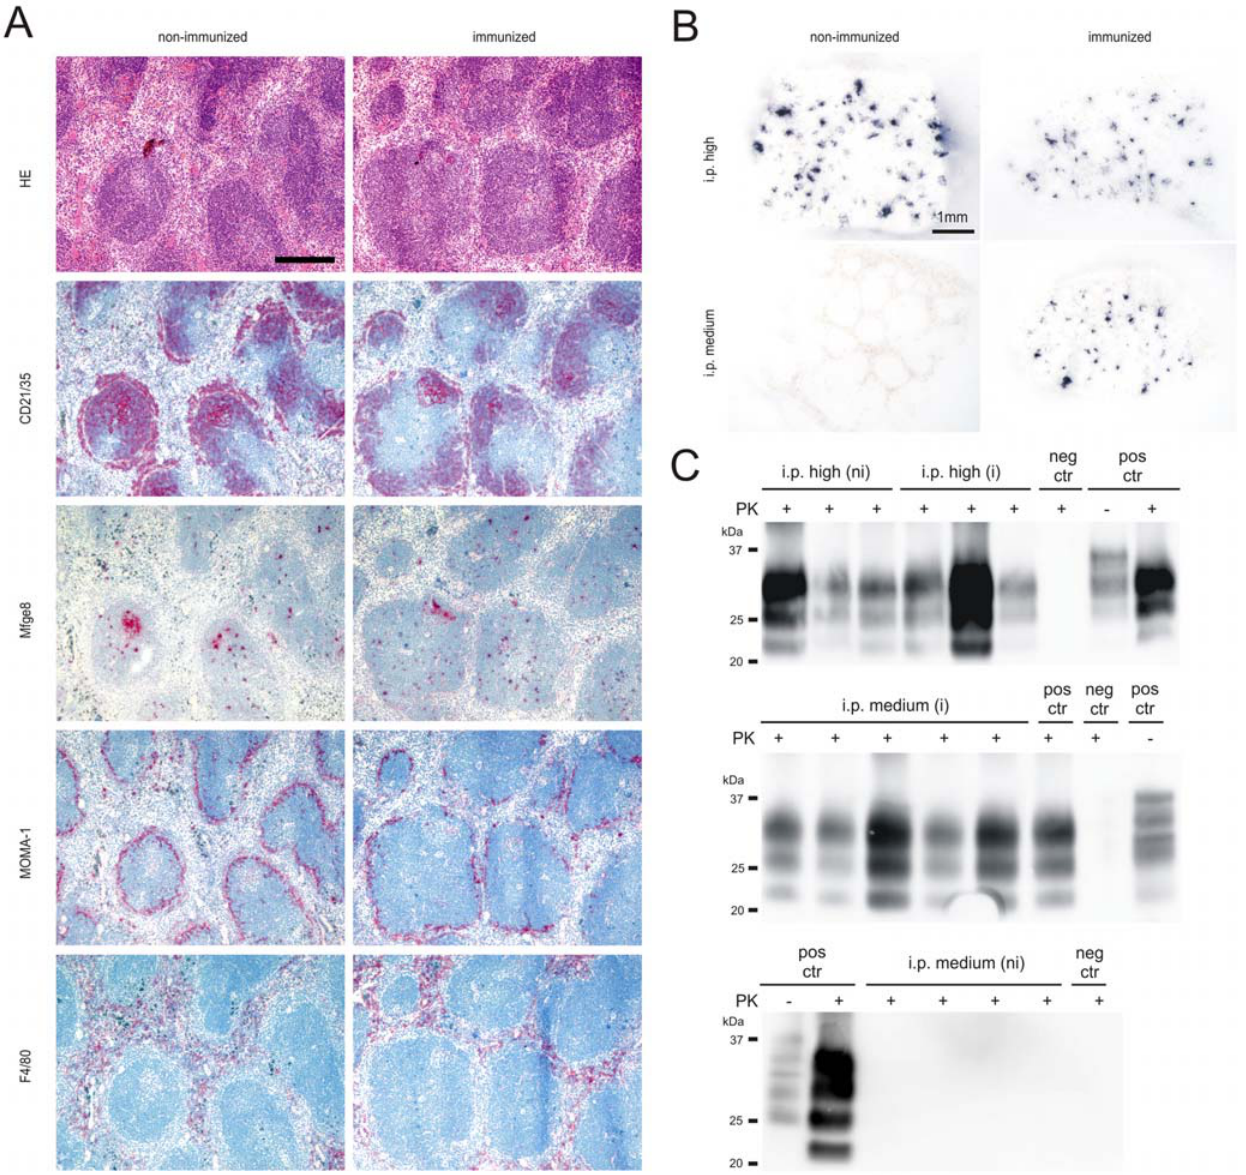
Figure 7. Histology, histoblots, and Western blots of spleens from terminally sick or asymptomatic mice. (A) Spleens of immunized (i) and non-immunized mice (ni) inoculated intraperitoneally (i.p.) with medium or high dose of prions were analyzed by histology. Histological and immunohistochemical stains were performed as indicated. MOMA-1 + cells were reduced in immunized mice. All terminally sick mice of the various experimental groups carried PrP Sc in their spleens as shown by histoblot (B) and confirmed by Western Blot (C) . Asymptomatic, non-immunized mice inoculated i.p. with a medium dose of prions [i.p. medium (ni)] were killed at 400 dpi. No PrP Sc was detectable by histoblot analysis (B) and Western blot analysis (C) . Controls and abbreviations are as in Fig. 6. Scale bars: histoblot=1 mm; histology=200 m